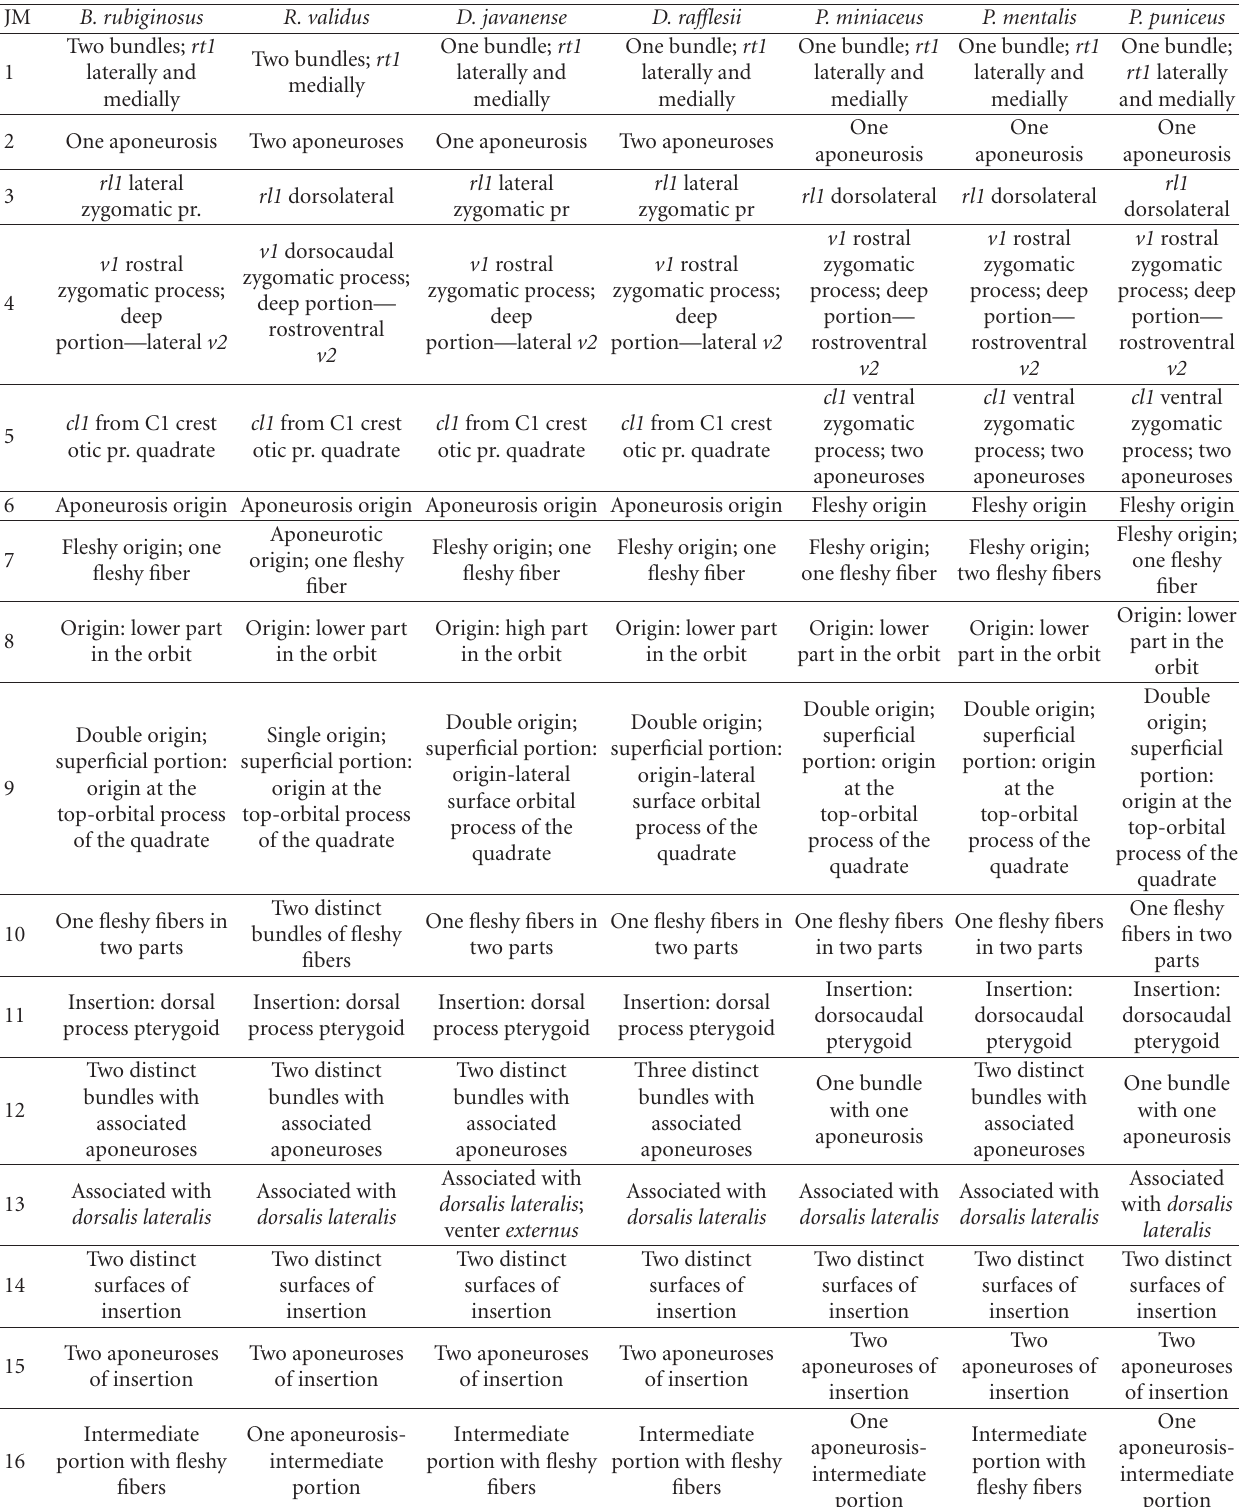
Table 1: Aspects of the jaw musculature compared among the species of the